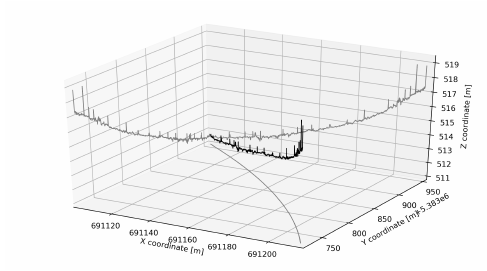
Figure 7. The projected line on DSM.